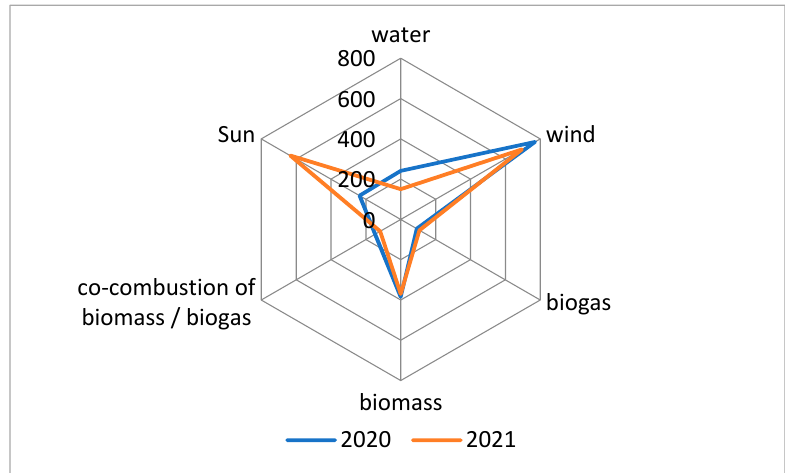
Figure 8. Electricity production from RES (GWh) in Poland [45].